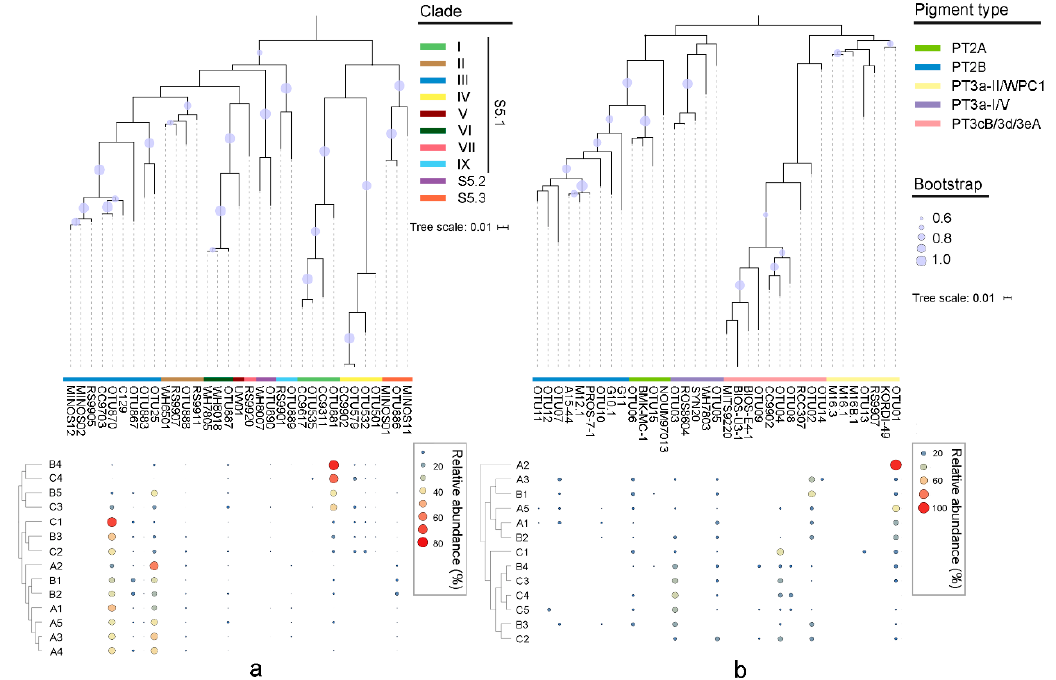
Figure 3. Maximum likelihood phylogenetic tree of the 15 most abundant OTUs based on rpo C1 gene ( a ) and cpe BA operon ( b ). Heatmaps on the bottom show the relative abundance of OTUs in each library.